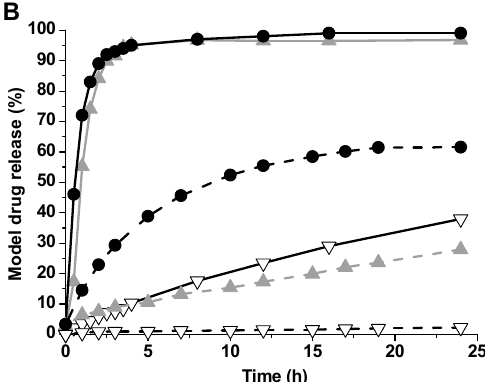
Figure 8. ( A ) Drug model (fluorescent dye DY-676) distribution in human colon carcinoma-bearing nude mice after injection of star-like HPMA-based copolymers containing different spacers—4-(2-oxopropyl)benzoyl (OPB), 4-isopropyl-4-oxobutanoyl (IPB), and 4-oxo-4-(2-pyridyl)butanoyl (PYR) spacers. (Reprinted with permission from [32], Copyright [2017], Elsevier). ( B ) Release of drug model from the copolymers incubated in phosphate buffered saline at pH 5.0 ( ● ── OPB; ▲ ── IPB; ── PYR) and pH 7.4 ( ● - - - OPB; ▲ - - - IPB; - - - PYR) at 37 °C.